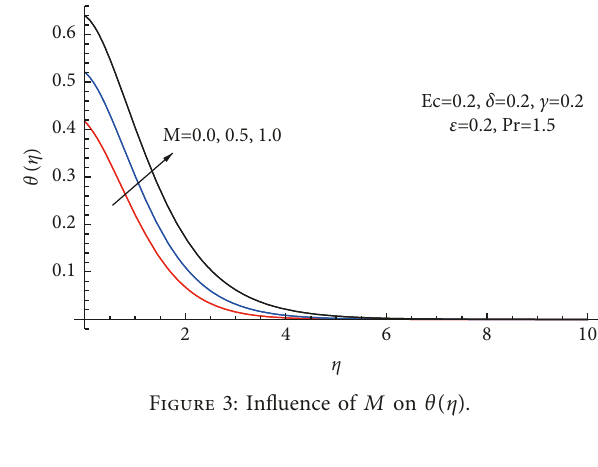
Figure 2: Influence of M on f ′ ( η ) .